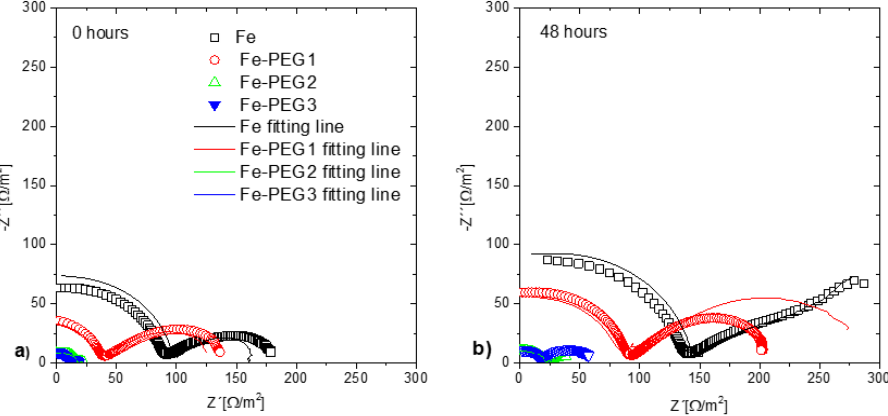
Figure 12. Nyquist plots of open cell iron samples with and without PEG coating before immersion ( a ) and after immersion in Hanks’ solution for 48 h ( b ).